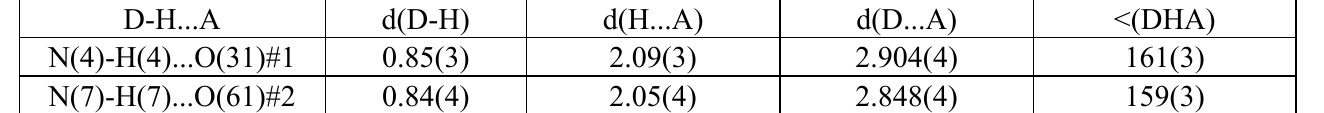
Table 2. Hydrogen bonds for (Z-AF-OMe) [Å and